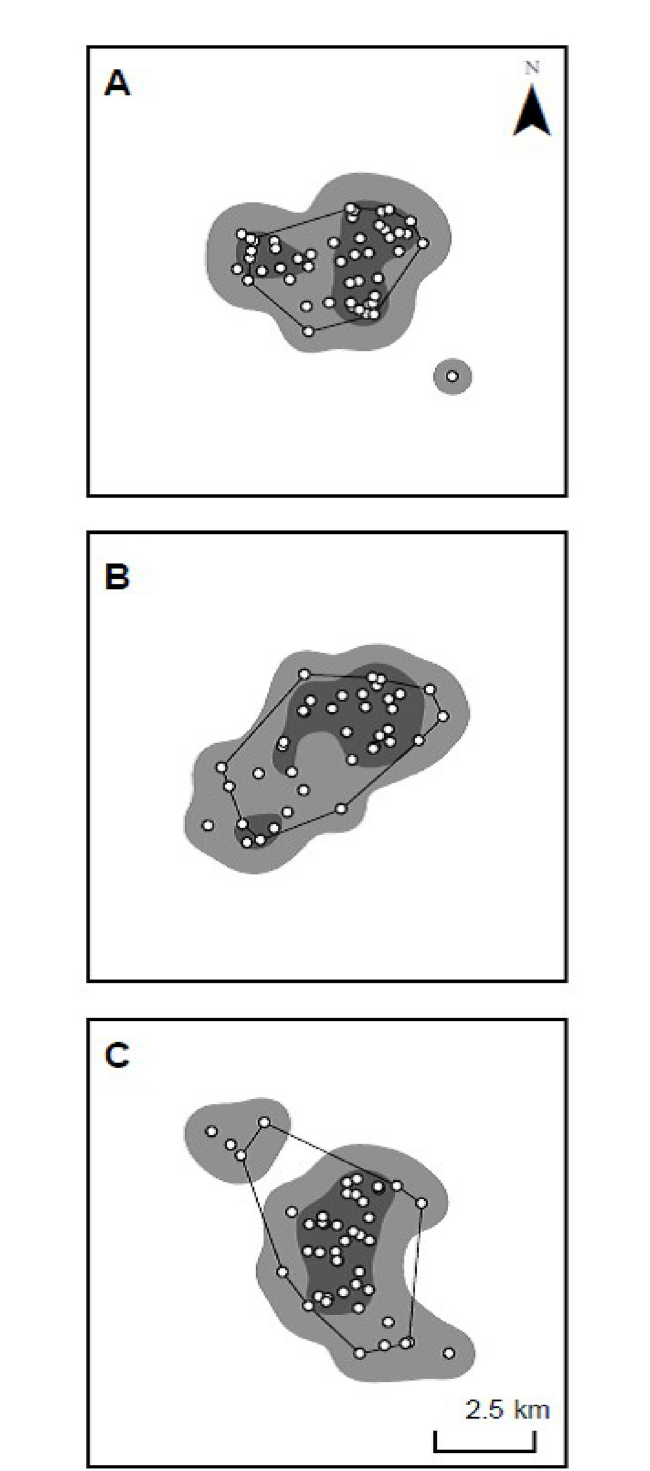
Fig 1. Illustrated comparison of the two analysis techniques used for producing annual black rhino home-range estimates in Hluhluwe-iMfolozi Park, South Africa. Comparisons are illustrated for the ranges of three rhinos designated A, B and C. Actual positions from radio-telemetry relocation are illustrated by the white filled circles. Contours of bivariate kernel utilisation distributions are illustrated by the 50% (dark grey) and 95% (mid-grey), using a smoothing parameter (h) of 500 m and cell size of 100 m in an